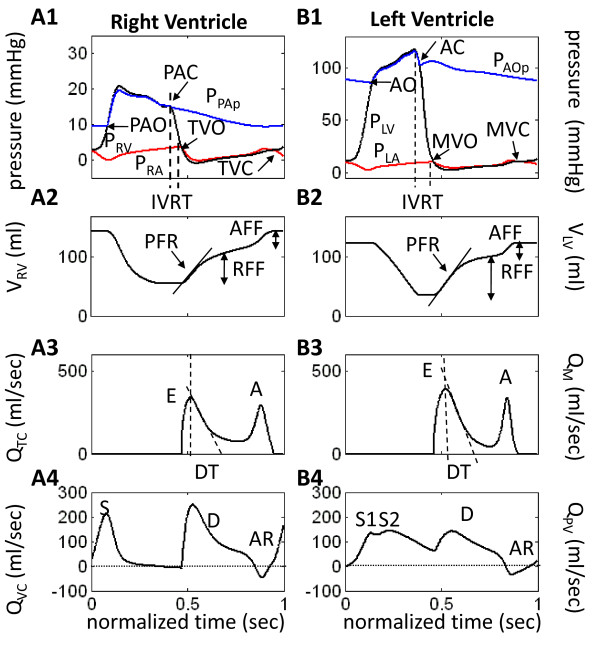
Model Waveforms for Right and Left Ventricles in Control Case. Model-generated pressure, volume and flow waveforms for the normal patient (control case). PFR = peak filling rate (slope of drawn line); RFF = rapid filling fraction; AFF = atrial filling fraction; IVRT = isovolumic relaxation time; DT = E-wave deceleration time; (P)AO/C = (pulmonary) aortic valve opens/closes; MVO/C = mitral valve opens/closes; TVO/C = tricuspid valve opens/closes.